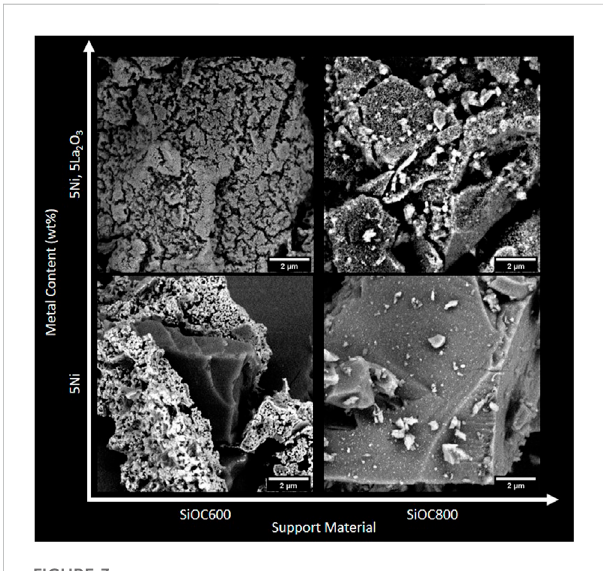
SEM images (BSE-contrast) of catalysts with (top row) and without (bottom row) La-modi fi cation as a function of pyrolysis temperature of the support material.